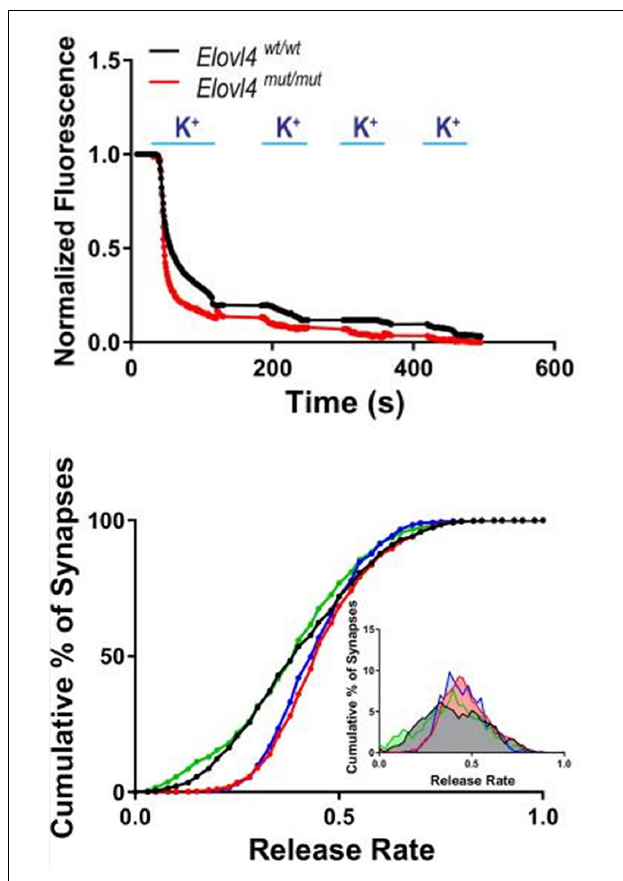
FIGURE 9 | Accelerated synaptic vesicle release in Elovl4 mutant neurons and its rescue by VLC-SFA. Top panel: Faster synaptic release in Elovl4 mut / mut hippocampal synapses (red) compared to WT control synapses (black), as detected with FM1-43 dye. Representative traces of average synaptic release activated by four rounds of high K + depolarization. Bottom panel: Cumulative graph depicts the fraction of total releasable synaptic vesicle pool exocytosed after 15 s depolarization (WT = black line). Vesicle release kinetics was recorded by FM1-43 fluorescence from 900 to 1200 synapses. Note the robust right shift of the cumulative distribution for Elovl4 mut / mut synapses (red), which is rescued by supplementation with 28:0 and 30:0 SFAs (green) but not by 24:0 (blue). Inset: Frequency distribution of responses with slowest responding synapses on the left, and the fastest on the right on the curve. Reproduced from Hopiavuori et al. (2018) with permission under the Creative Commons Attribution 4.0 International License (link to the Creative Commons license;